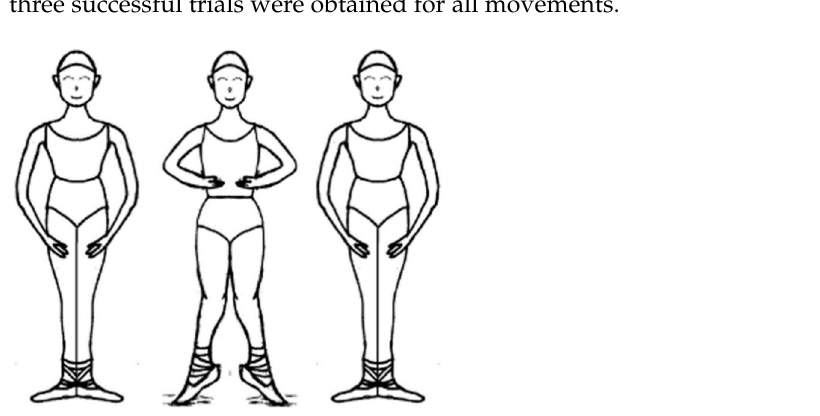
Figure 1. Releve en demi-pointe.